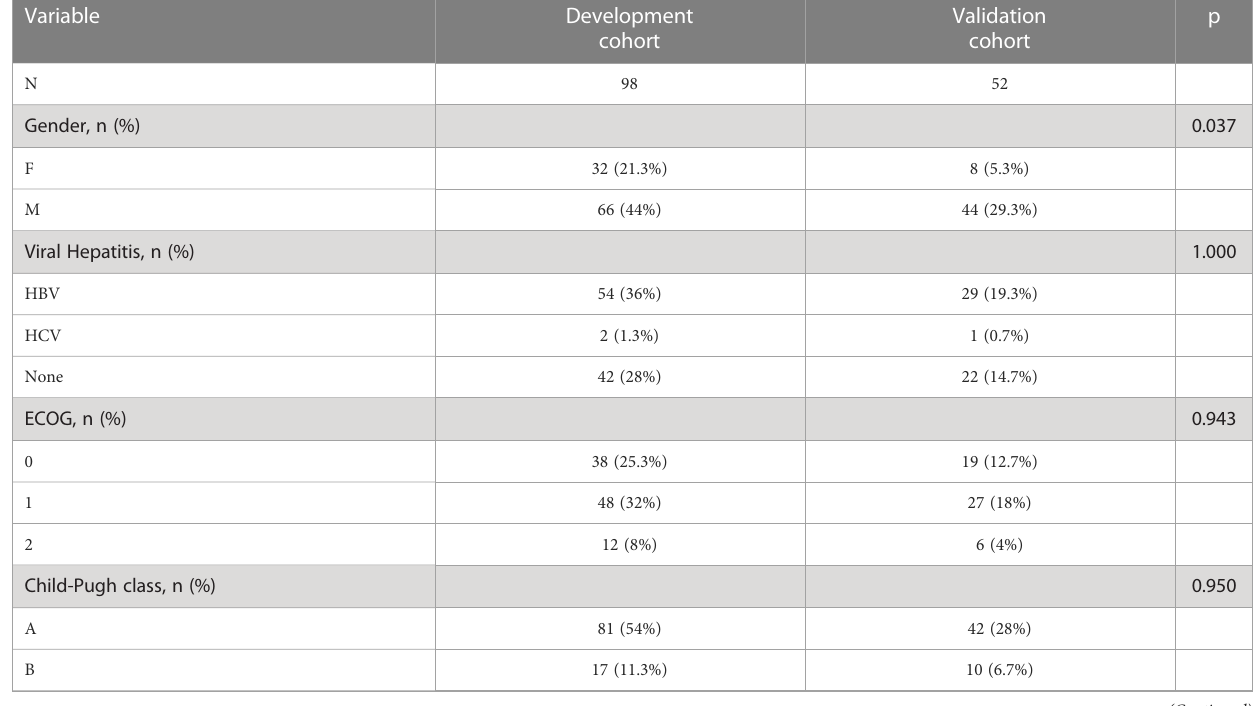
TABLE 1 Characteristics of clinical data in the modeling and validation groups.